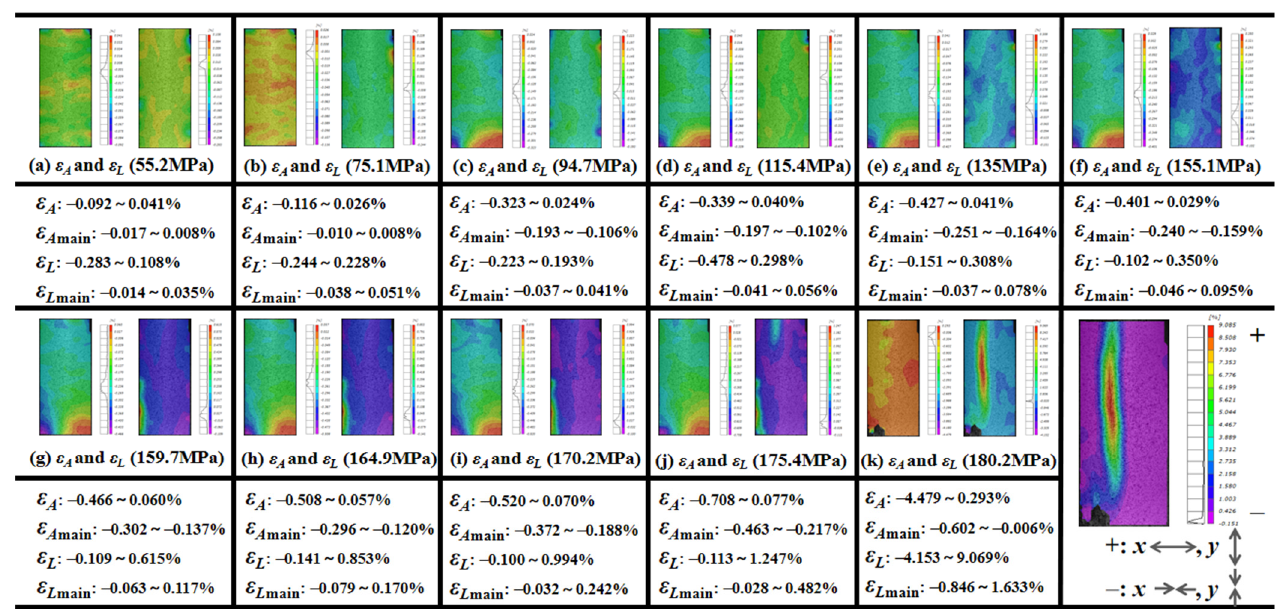
Figure 7. Variation range of axial and lateral creep strain with stress level for granite.